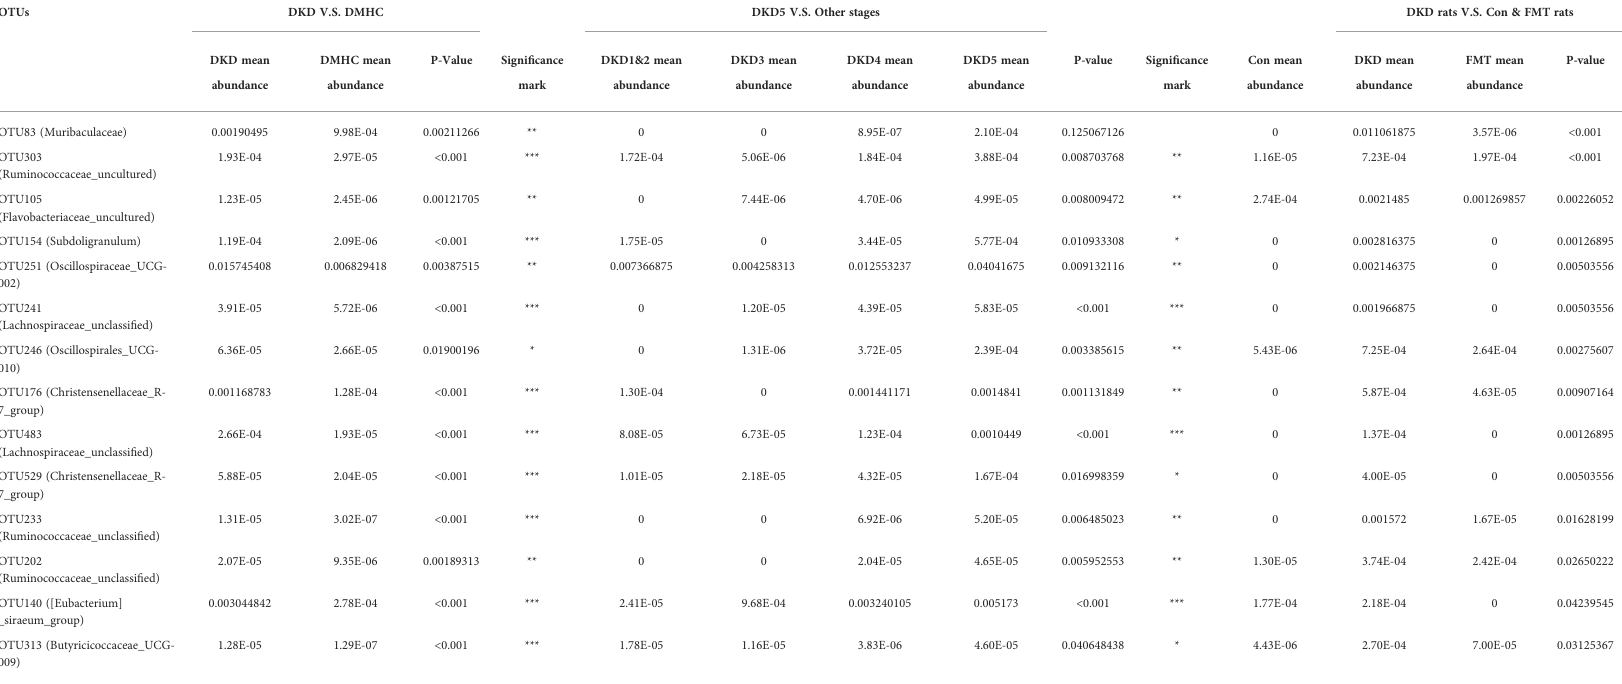
TABLE 3 The potentially harmful signi fi cantly accumulated OTUs shared by DKD when compared with DMHC, DKD5 when compared with other DKD stages, and DKD mice when compared with Con and FMT mice.